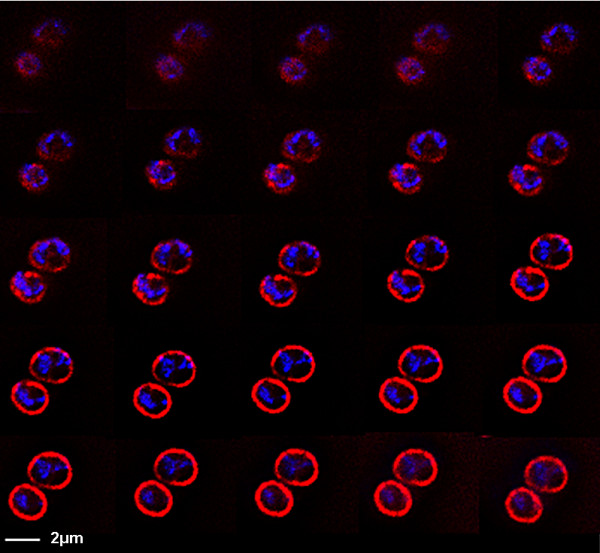
Optical sections of a pair of D. radiopugnans cells. The series is in order from left to right of the images within a row and from top to bottom of the rows within the figure. Images are taken at 100 nm intervals.